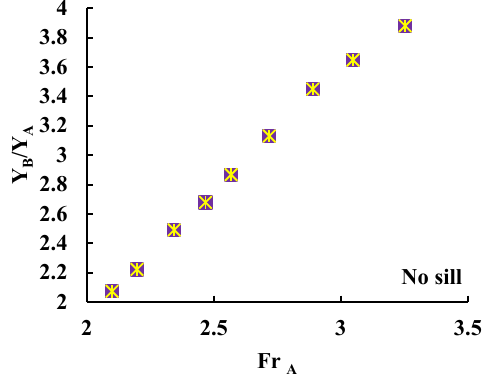
Figure 5. Relative depth changes.